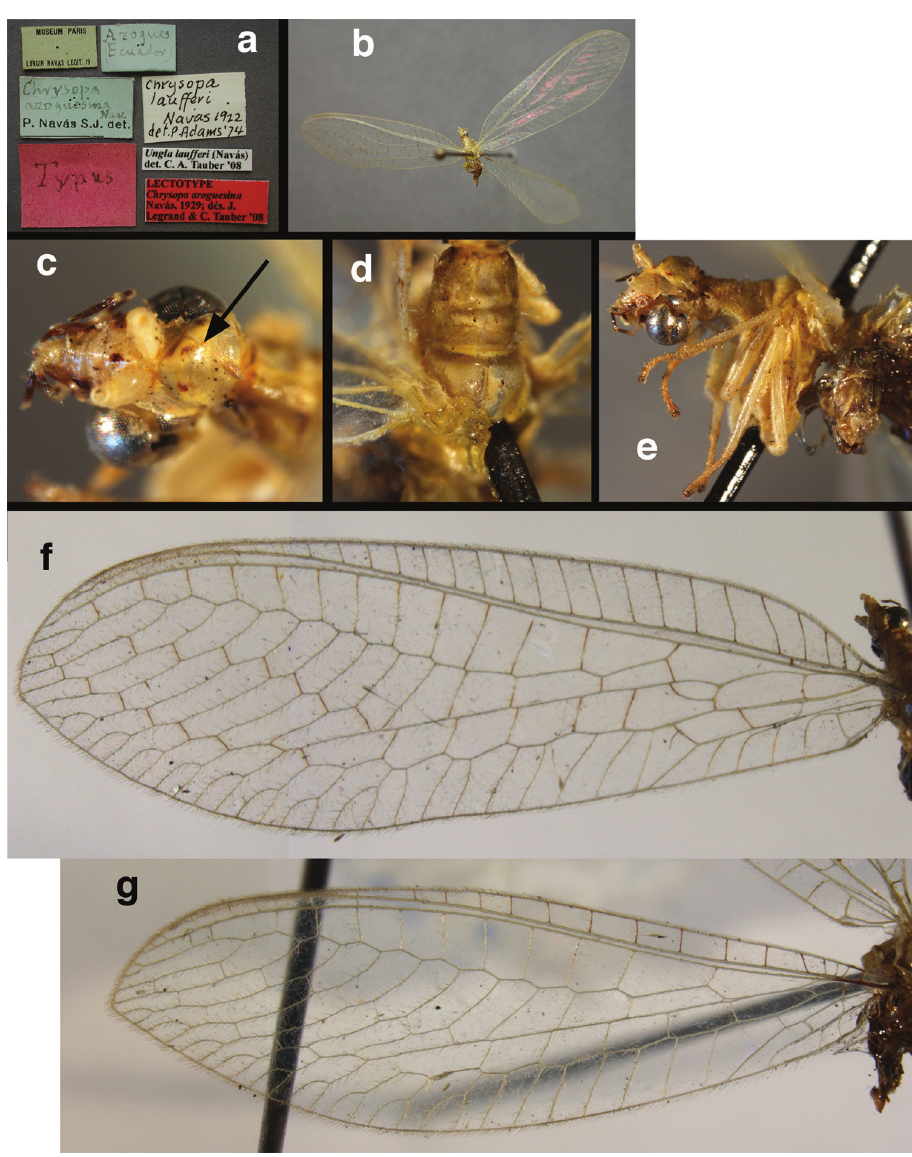
Figure 50. Chrysopa aroguesina Navás: External features, ( a ) labels ( b ) habitus, dorsal ( c ) head, dorsal [Arrow indicates red marks on vertex.] ( d ) prothorax, mesothorax, dorsal ( e ) head, thorax, dorsolateral ( f ) forewing ( g ) hindwing (Ecuador, Azogues, lectotype, female, MNHN). long, 0.4–0.5 mm wide (ratio, L : W = 4.6–5.5 : 1); 4–5 Banksian cells (b cells), 4–5 b’ cells; 6–7 inner gradates, 6–8 outer gradates. Hindwing 12.0–14.4 mm long, 3.8–4.5 mm wide (ratio, L : W = 3.1–3.3 : 1), 11–14 radial cells, 3–4 Banksian (b) cells, 4–5 b’ cells, 5–7 inner gradates, 3–8 outer